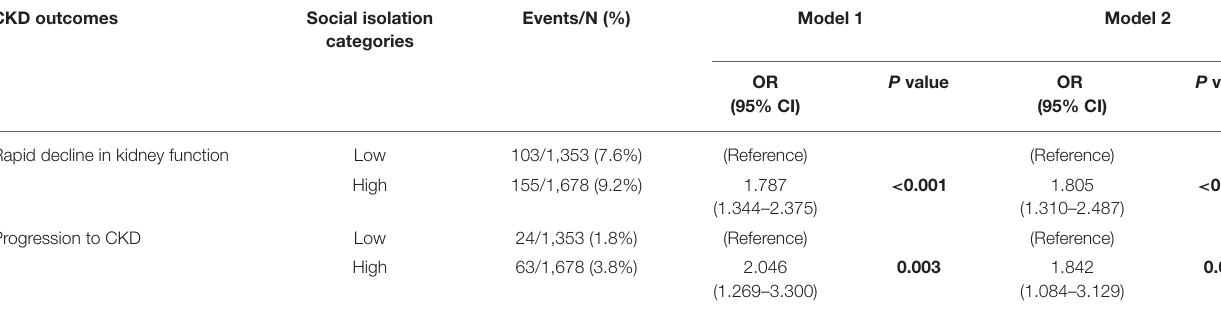
TABLE 2 | The relationships of social isolation and CKD outcomes.